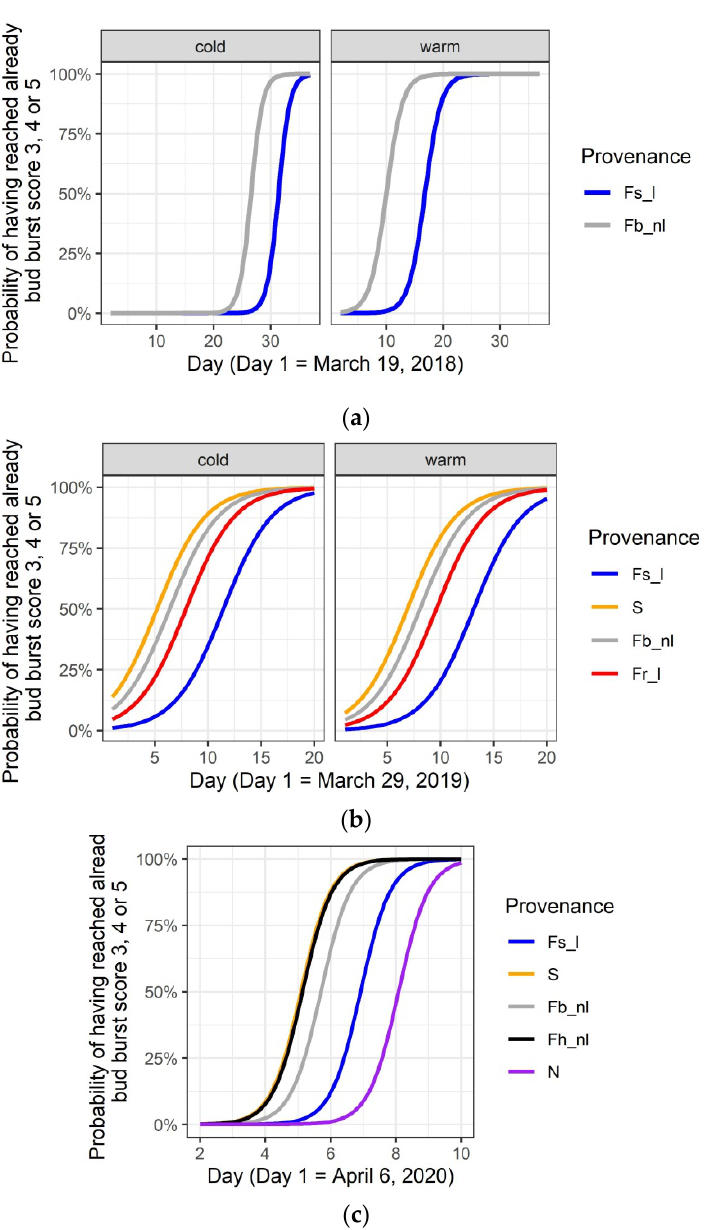
Figure 11. Differentiation among the provenances in the modelling analysis. Only the provenances that differ significantly from the standard provenance Sonian are shown: modelled bud burst in 2018 ( a ) and 2019 ( b ) for the two temperature conditions in the spring of 2018; modelled bud burst in 2020 ( c ). Abbreviations of provenances are in Table 1.